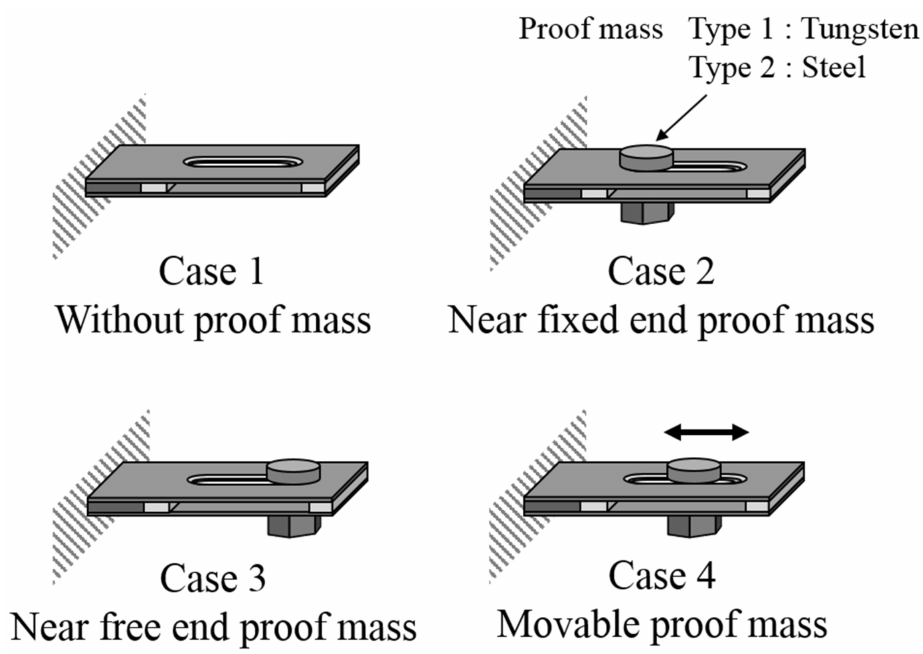
Figure 2. Schematic of a device with a proof mass.